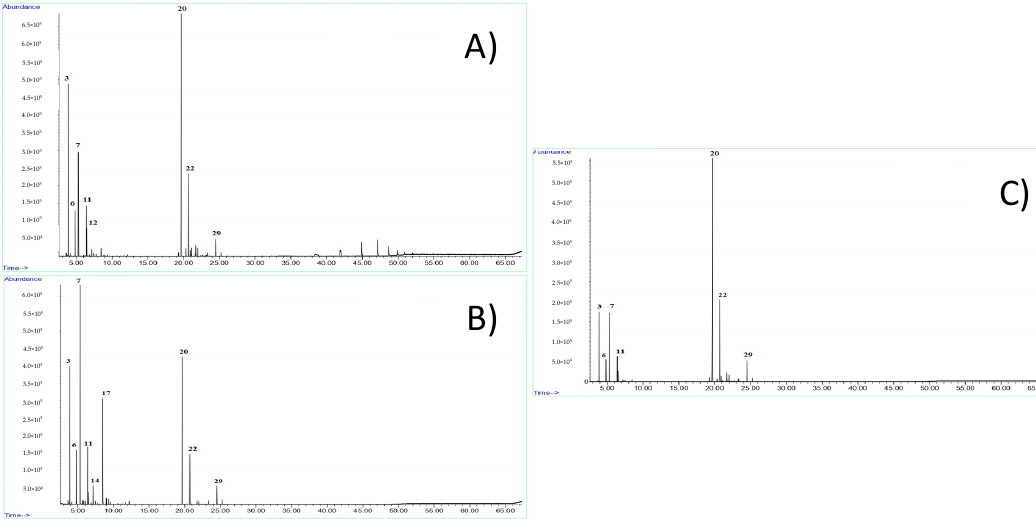
Figure 1. GC-MS chromatograms of the hemp essential oils obtained from the monoecious Felina 32 inflorescence ( A ), and female ( B ) and male ( C ) inflorescences of CS. Peak numbering refers to Table